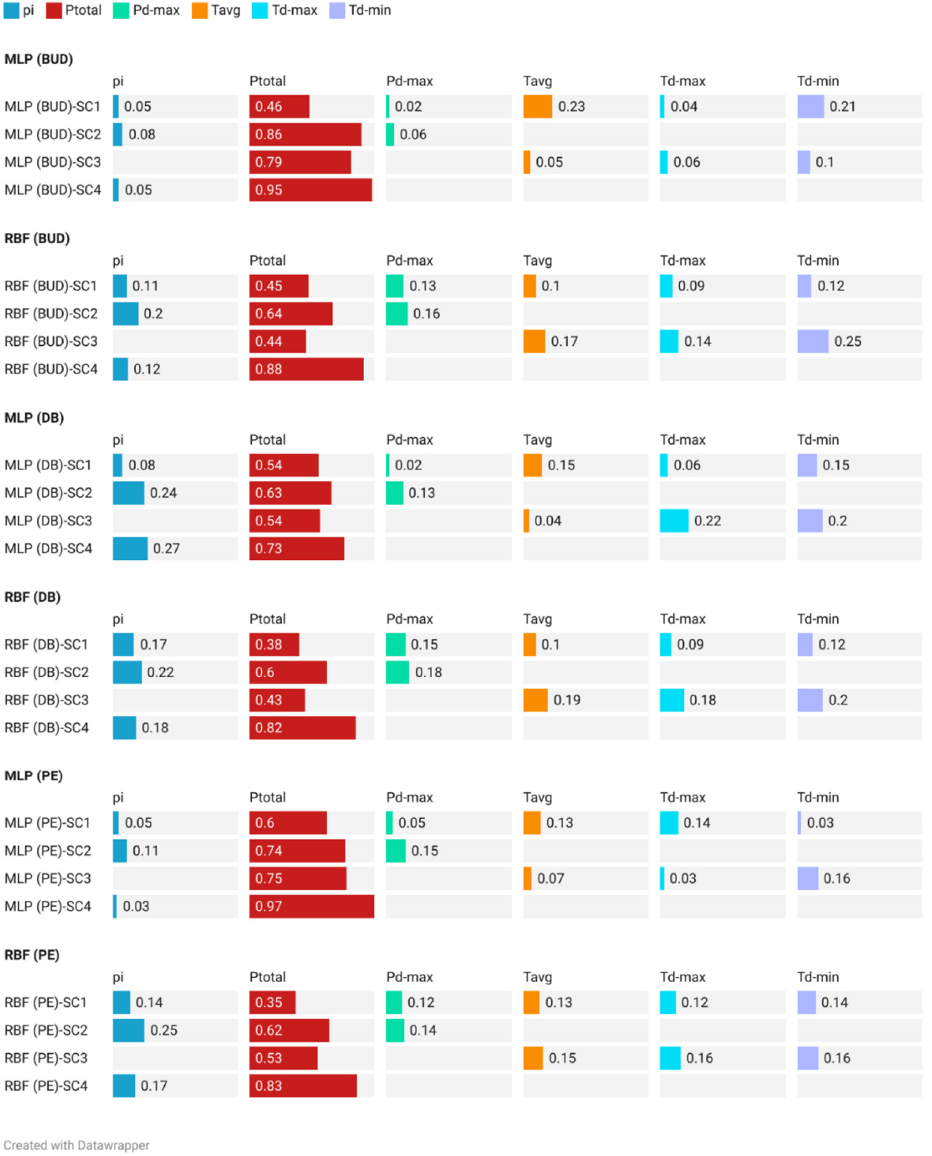
Figure 10. Sensitivity analysis for ANN (MLP and RBF) algorithms in the studied station under four scenarios.